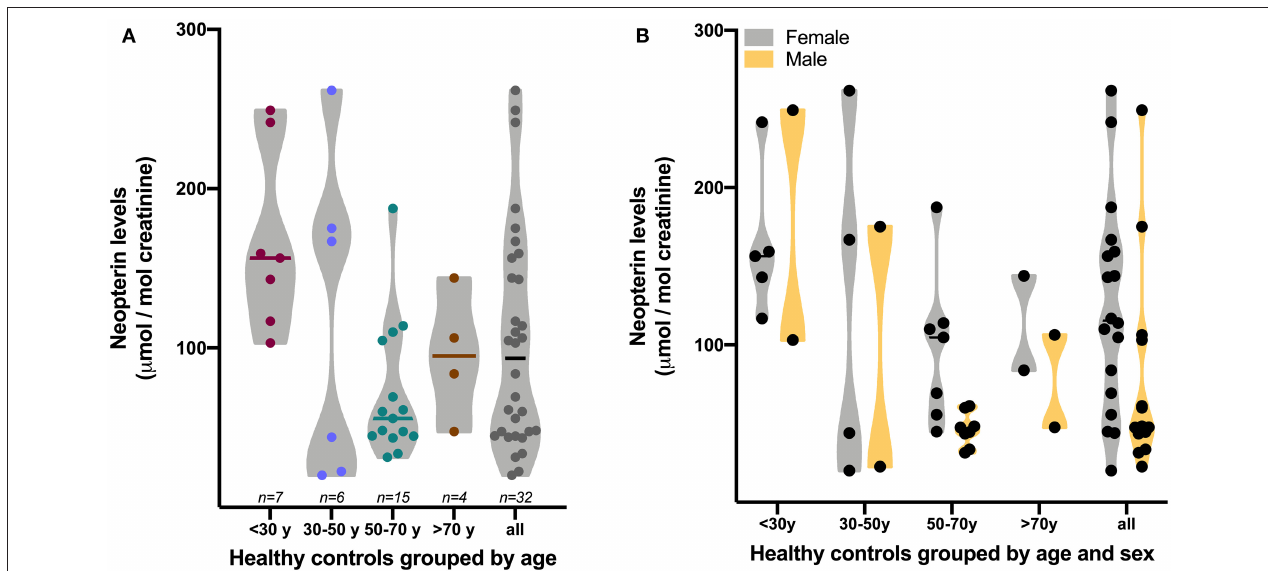
FIGURE 1 | Levels of neopterin in the urine of healthy controls grouped by age (A) or age and sex (B) . Neopterin levels were assessed in urine samples collected in the morning with a minimum of 2h retention in a collector plastic cup. Neopterin quantification was performed by liquid chromatography coupled with fluorescent detection as previously reported by our group (Scheffer et al., 2019). Graph was generated with GraphPad Software version 9.